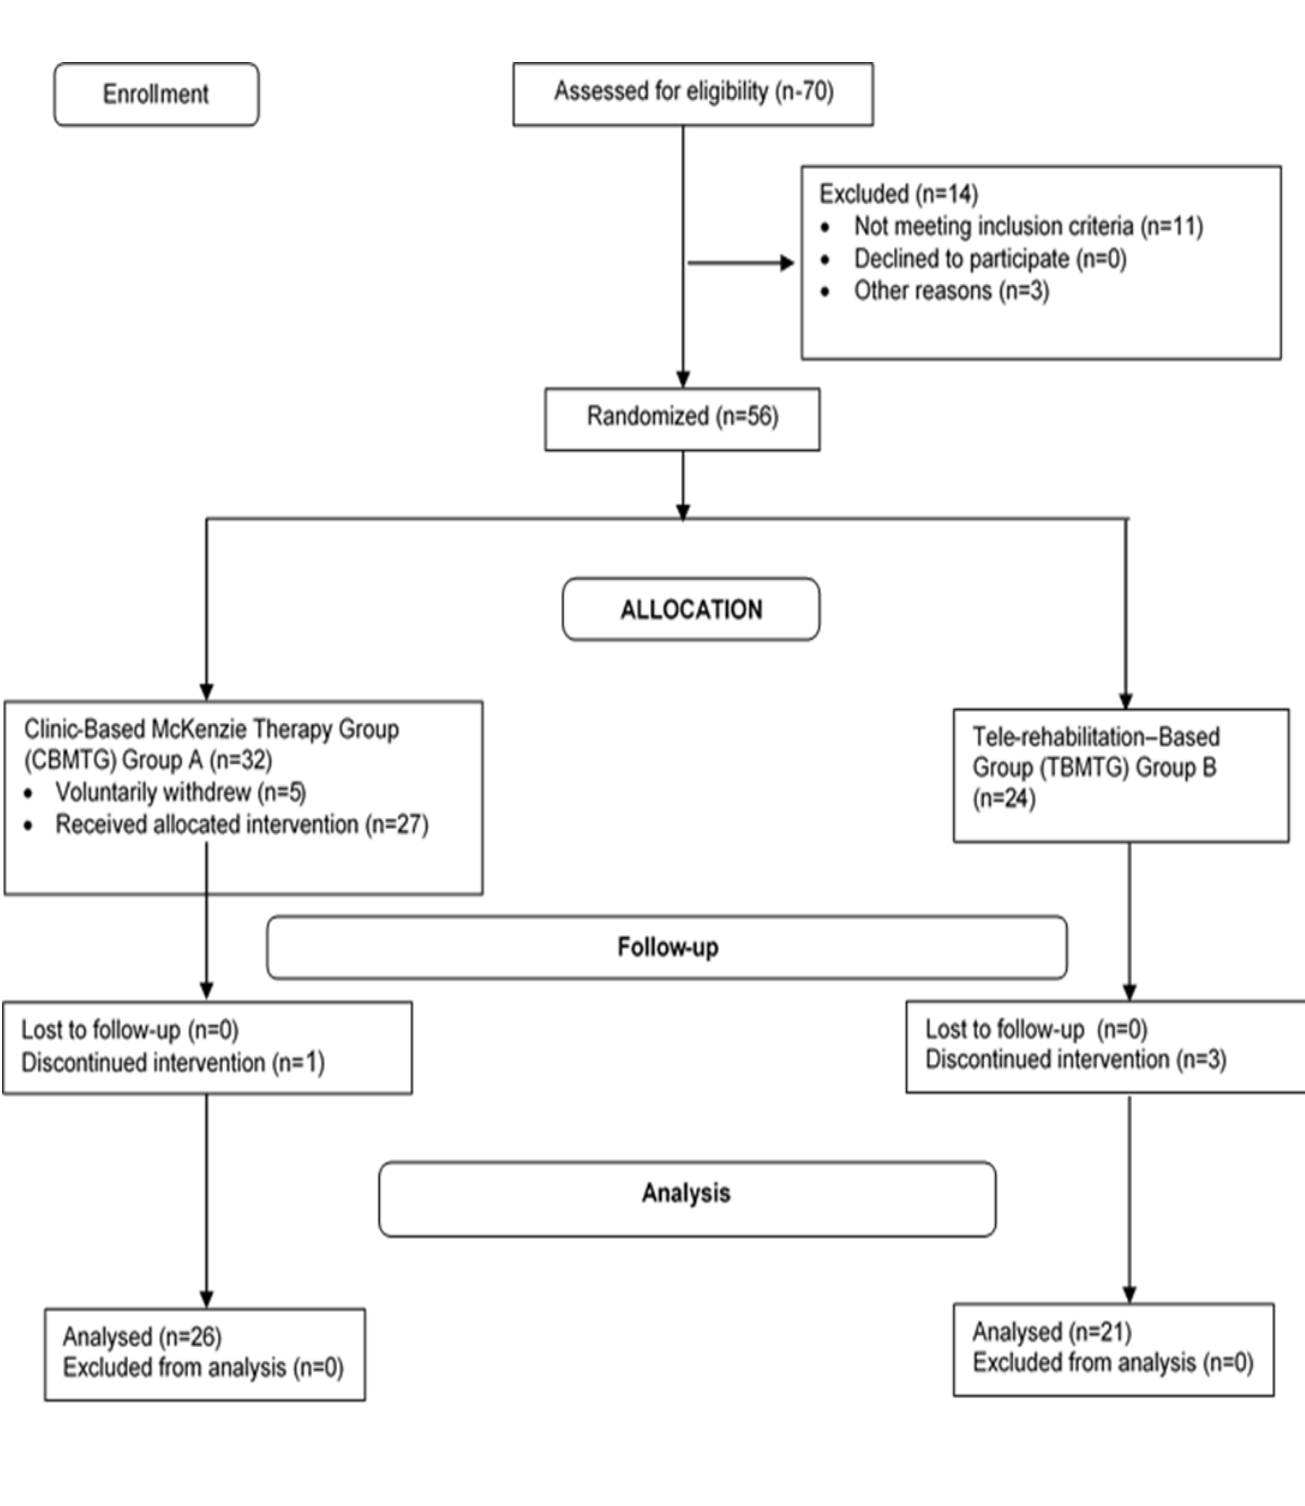
Figure 1. CONSORT showing the progression of patients through the